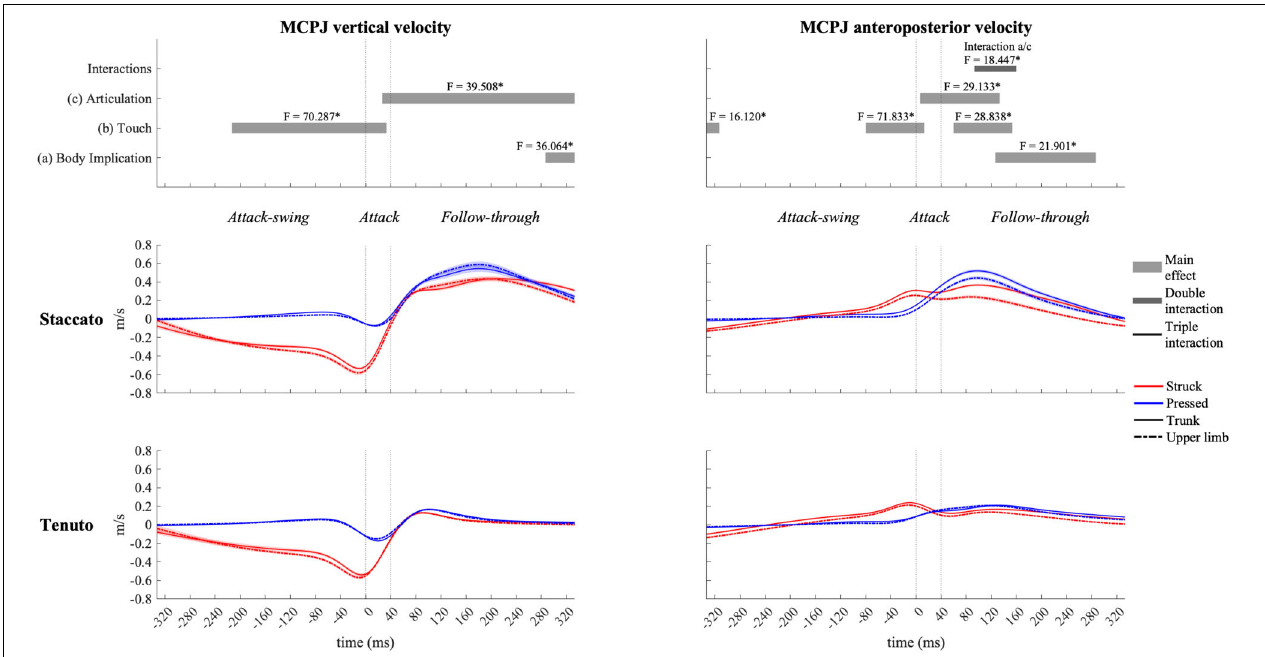
FIGURE 4 | Mean values (solid and dash-dotted lines) and 95% bootstrap confidence interval (shaded areas) of metacarpophalangeal joint (MCPJ) linear velocities during the three phases of the keystroke. Negative/positive values indicate downward/upward velocities and backward/forward velocities. Top panels represent the results from the statistical parametric mapping of time-series values. * p -value ≤ 0.001.